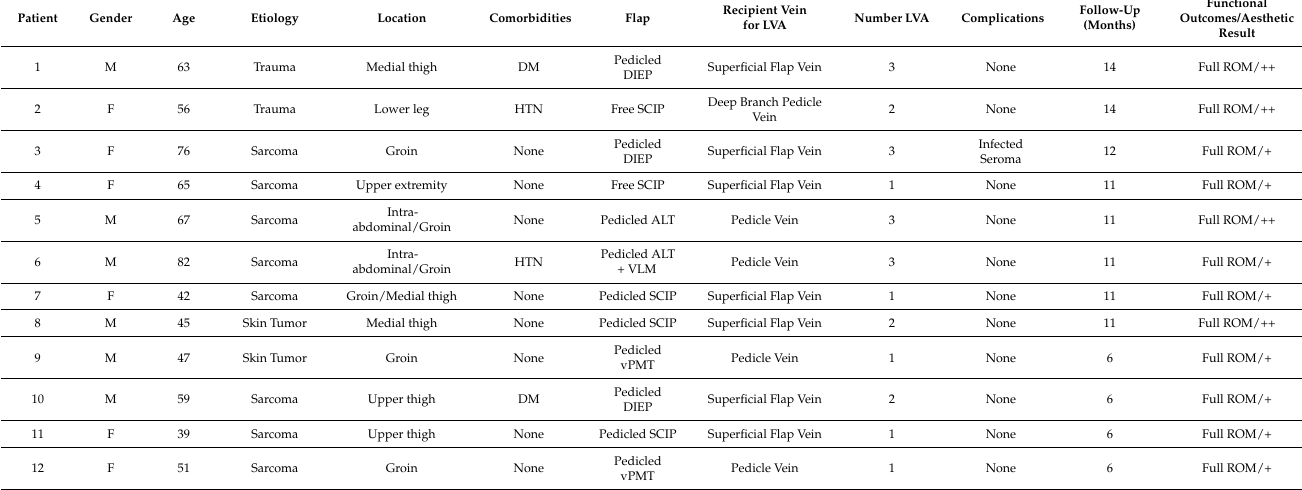
Table 1. Patient demographic and case